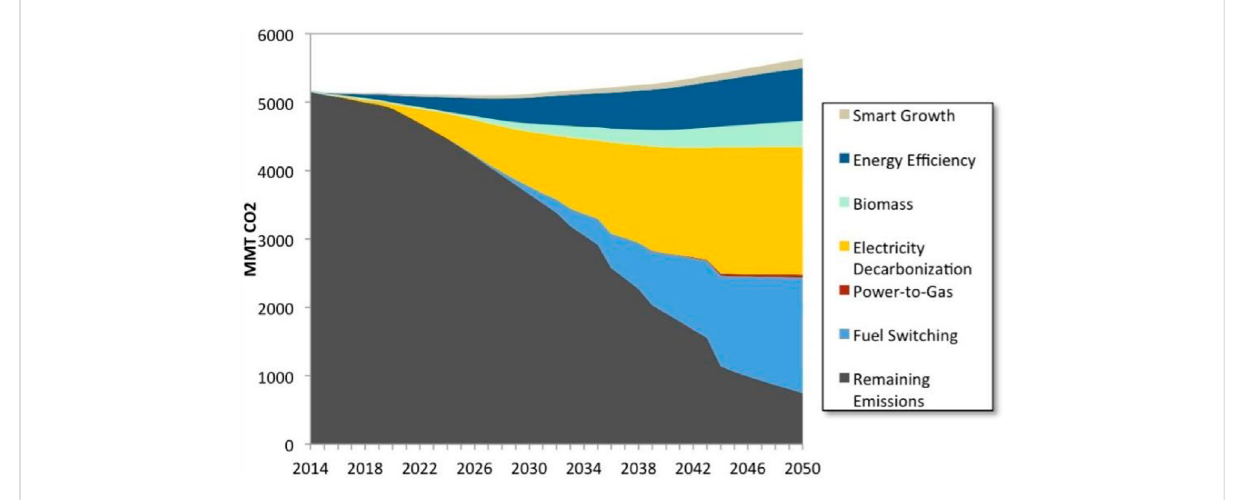
FIGURE 5 Deep carbonization forecast modeling in developing countries.